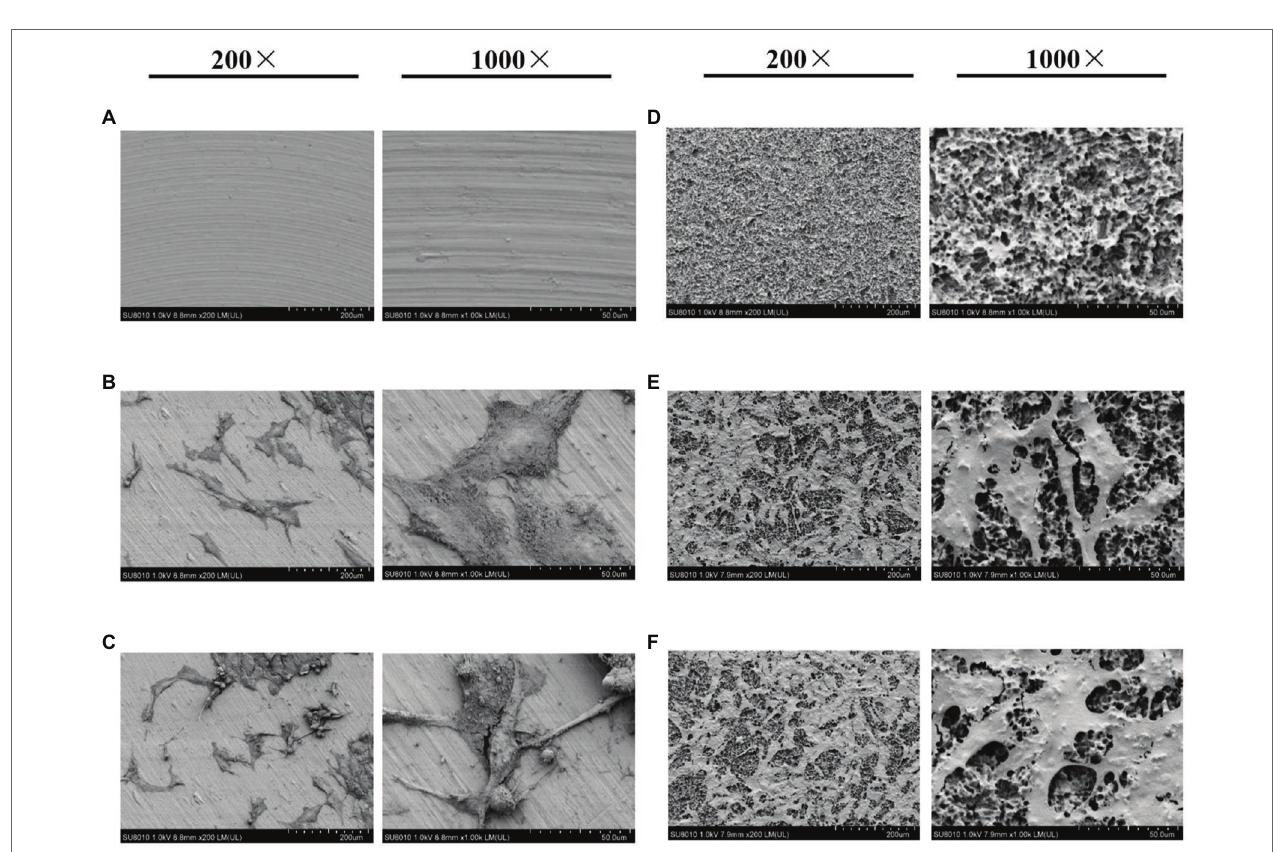
FIGURE 1 | Scanning electron microscopy (SEM) images of titanium plates and osteoblasts. (A) Smooth titanium plate, (B) MG-63 cells on a smooth surface under normoxic conditions, (C) MG-63 cells on a smooth surface under hypoxic conditions, (D) Rough titanium plate, (E) MG-63 cells on a rough surface under normoxic conditions, and (F) MG-63 cells on a rough surface under hypoxic